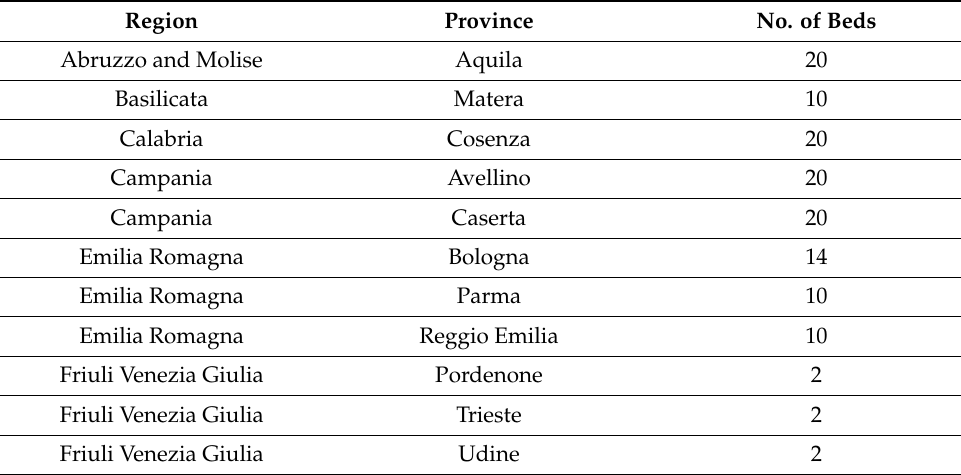
Table 1. Distribution of REMS beds in